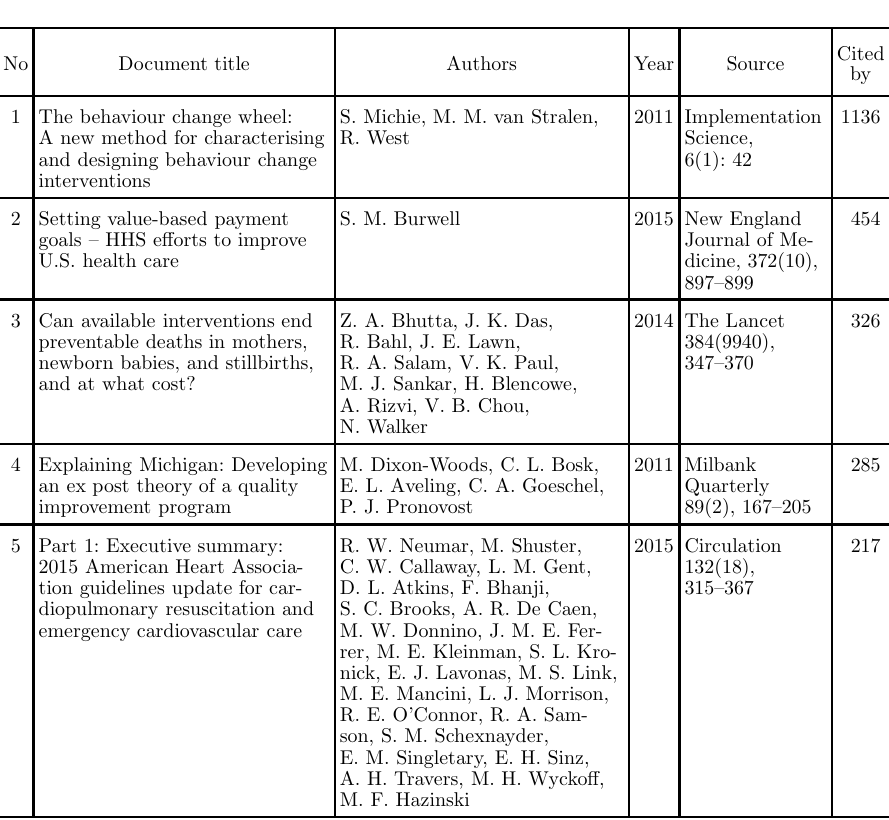
Table 3. List of publications on the quality of medical services in the Scopus database in 2011–2017 with the highest numbers of